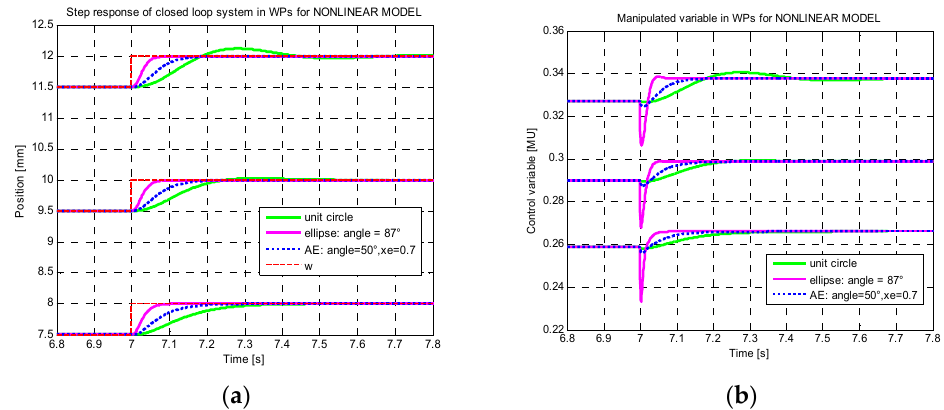
Figure 11. Simulation results for the nonlinear ML model in 3 working points (WP) for the designed robust pole placement controller for unit circle (green), elliptic approximation for damping angle 87° (magenta), and ellipse-cone (AE: blue dots): ( a ) Output variable—ball position; ( b ) control variable—current in the coil.